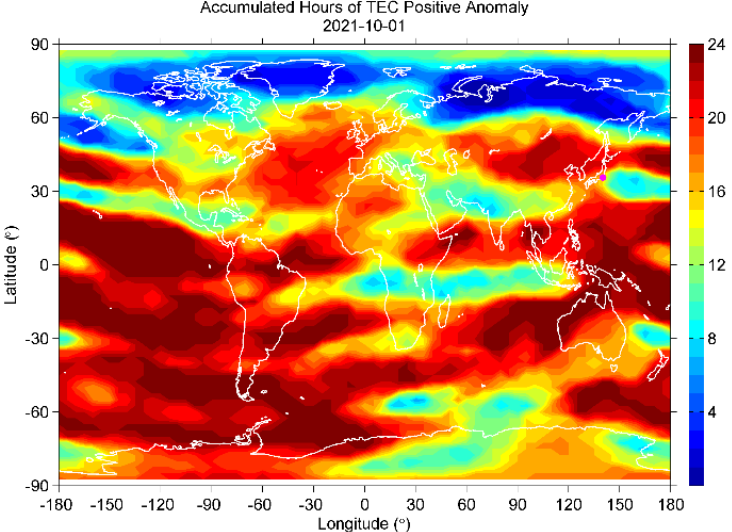
Figure 20. Same as in Figure 19, but for 1 October.